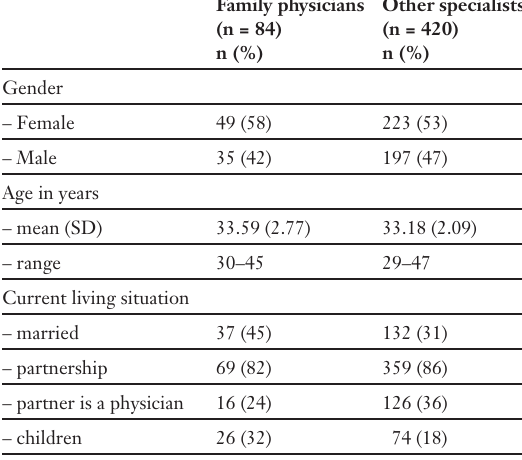
Sociodemographic characteristics of future family physicians versus other